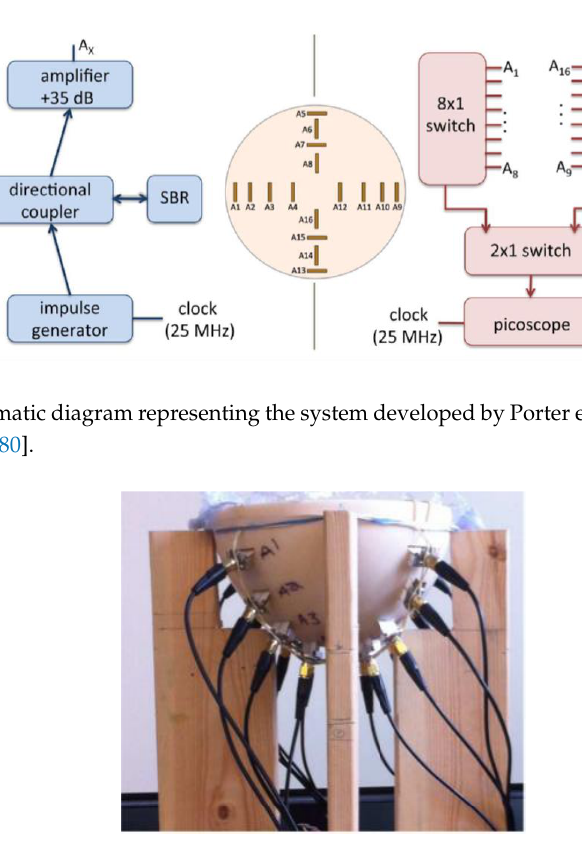
Figure 23. A breast cancer detection system using an antenna array with radome, developed by Porter et al. [80]. Reprinted with permission from [80].